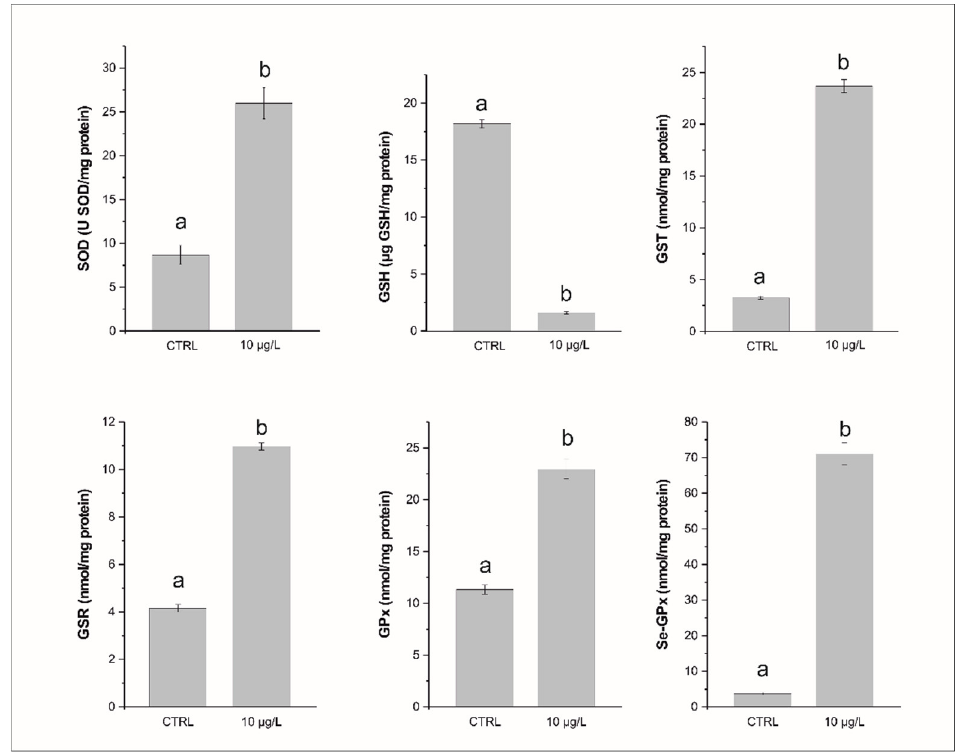
Figure 1. Levels of total superoxide dismutase (SOD), glutathione (GSH), the glutathione S-transferase (GST), glutathione reductase (GSR), glutathione peroxidase (GPx), and selenium-glutathione peroxidase (Se-GPx) in the symbiont-bearing foraminiferal species Amphistegina lessonii in samples exposed for 24 h at 10 µg/L of Hg and in control samples (no added Hg). Data are reported as mean ± standard deviation ( n = 5). Letters denote significant differences ( p < 0.01) between groups.